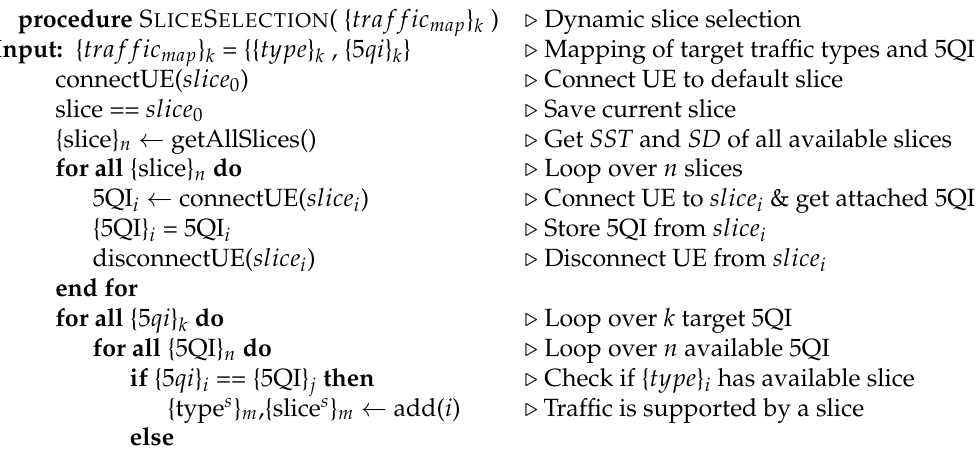
Algorithm 1 Algorithm for dynamic slice